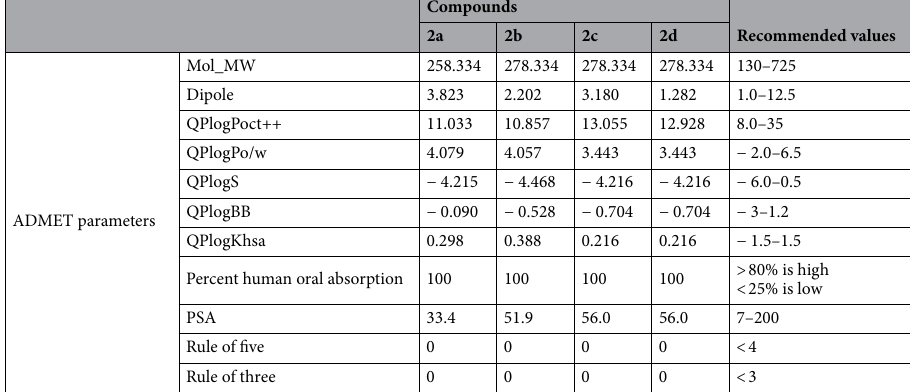
Table 4. The ADME properties of molecules 2a, 2b, 2c , and 2d using QiKProp module (schrödinger 10.9, LLC, NY) running in normal mode. Mol Mw: molecular weight of the molecule. Dipole: computed dipole moment of the molecule. QPlogPoct++: predicted octanol/gas partition coefficient. QPlogPo/w: predicted octanol/water partition coefficient. QPlogS: predicted aqueous solubility, S in mol dm −3 . QPlogBB: predicted brain/blood partition coefficient. QPlogKhsa: prediction of binding to human serum albumin. Percent Human Oral Absorption: predicted human oral absorption on a 0–100% scale. PSA: van der Waals surface area of polar nitrogen and oxygen atoms and carbonyl carbon atoms. Rule of five: number of violations of Lipinski rule of 5. Rule of three: number of violations of Jorgensen’s rule of